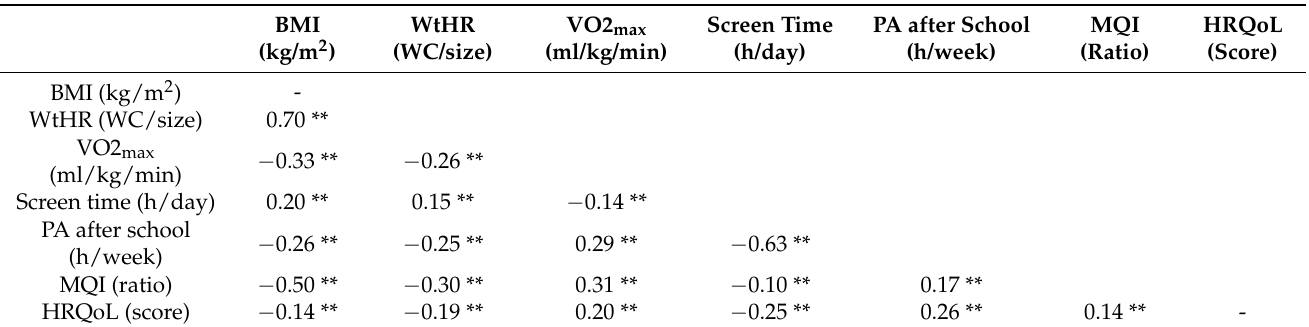
Table 2. Correlation among anthropometrics, abdominal obesity, fitness and health-related quality of